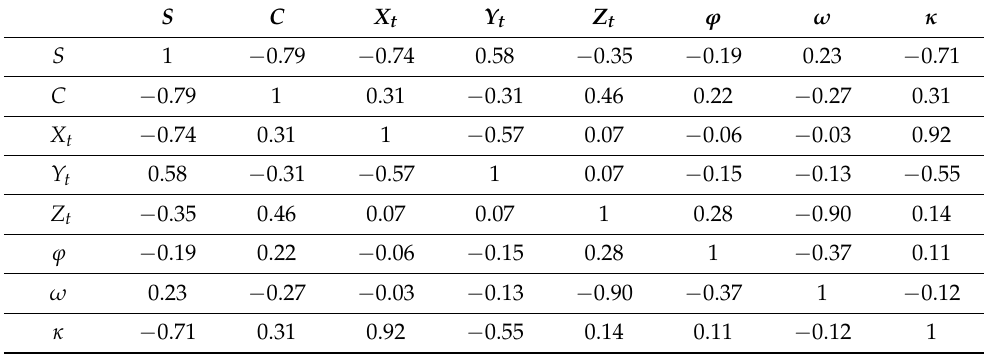
Table 17. The matrix of correlation coefficients of the unknowns for dataset DATA3.